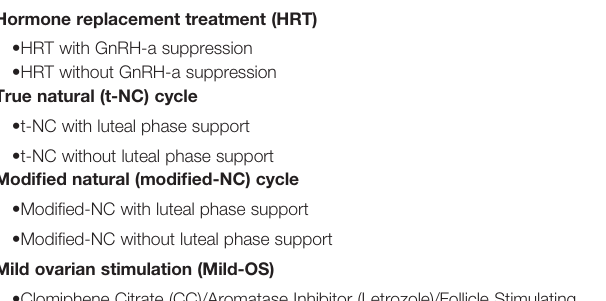
TABLE 1 | Endometrium preparation protocols for frozen embryo transfer